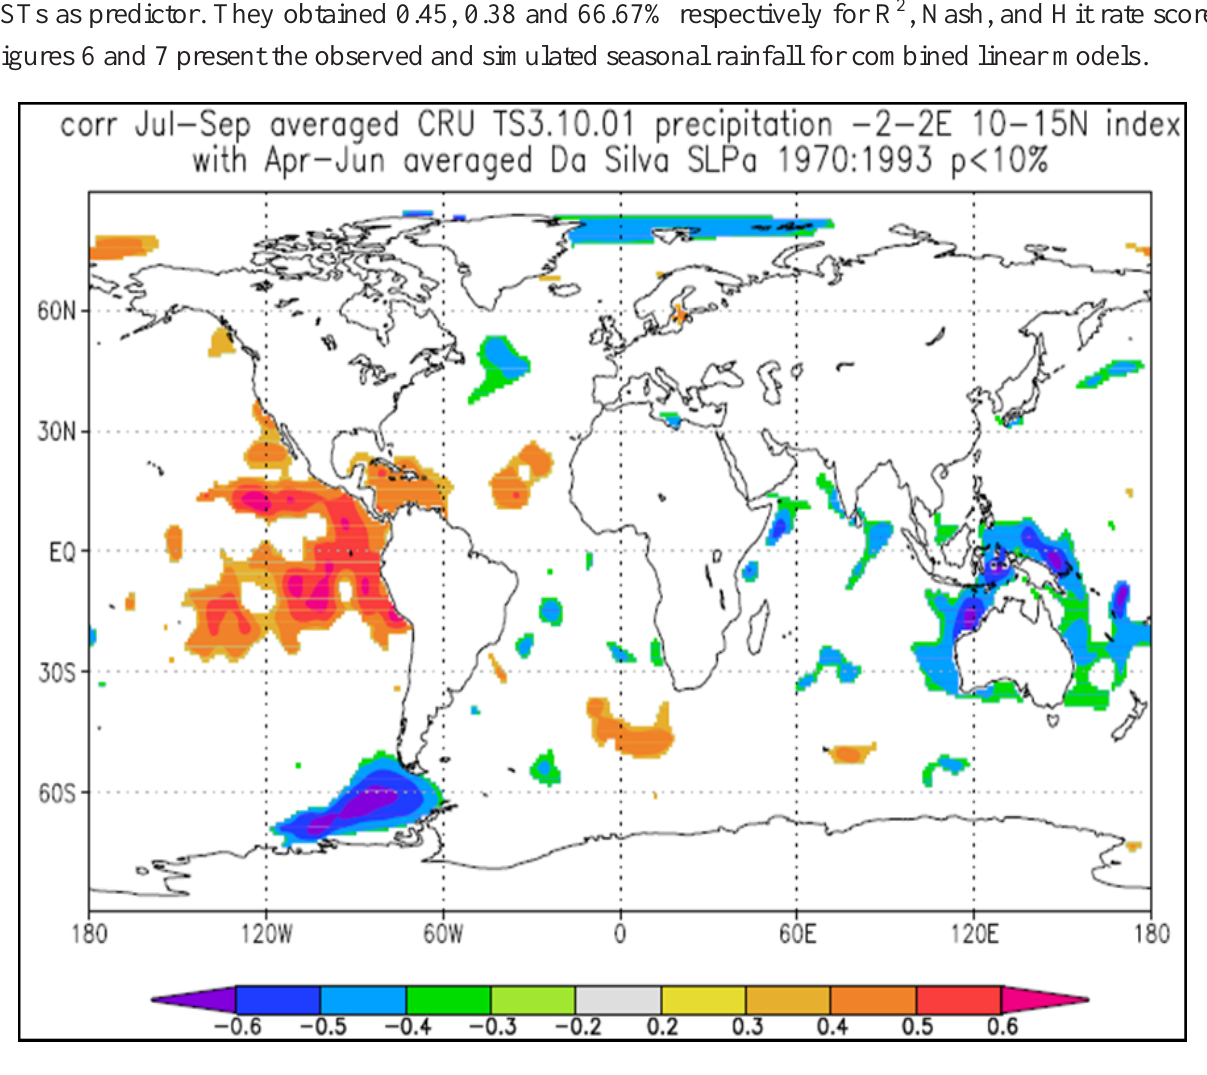
Figure 5. Correlation map between seasonal precipitation and sea level pressure (Da Silva analysis,